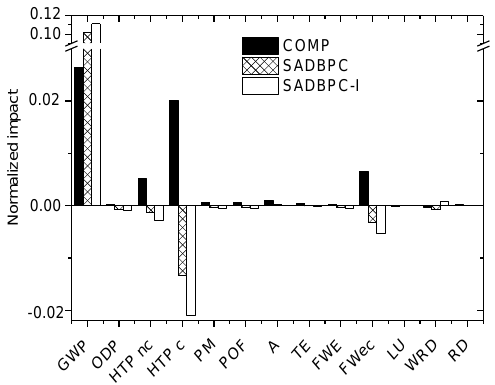
Figure 5. Normalized impact categories for the different scenarios.